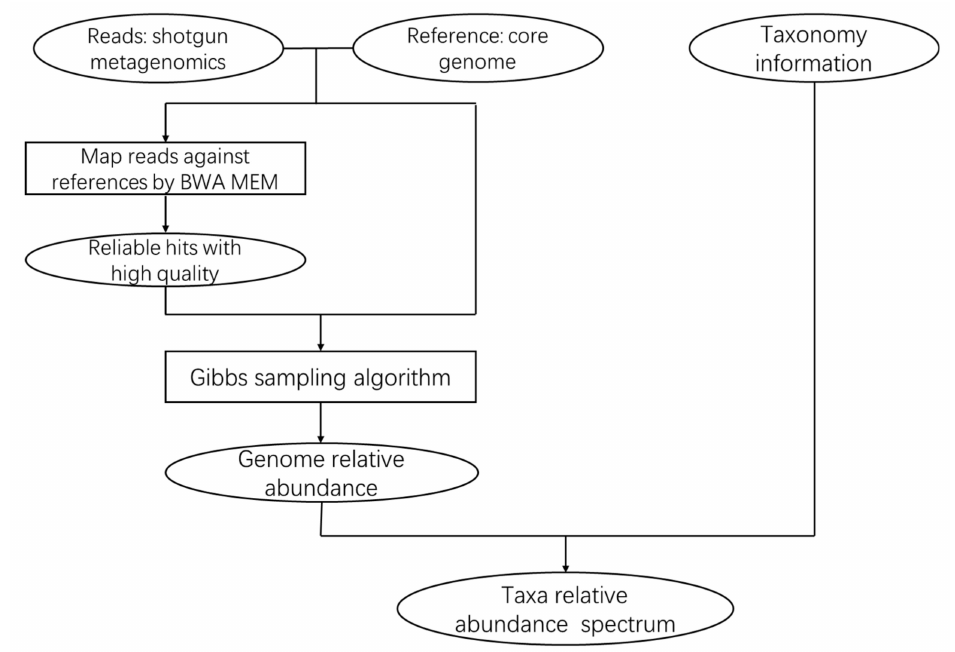
Figure 2. The CoreProbe framework. First, the metagenomic reads obtained by shotgun sequencing method was compared with the core genome reference sequence using BWA [27], and the results of the alignment were recorded. The results were then combined with our reads set and the reference sequences applied to the Gibbs sampling algorithm to obtain the relative abundance of the